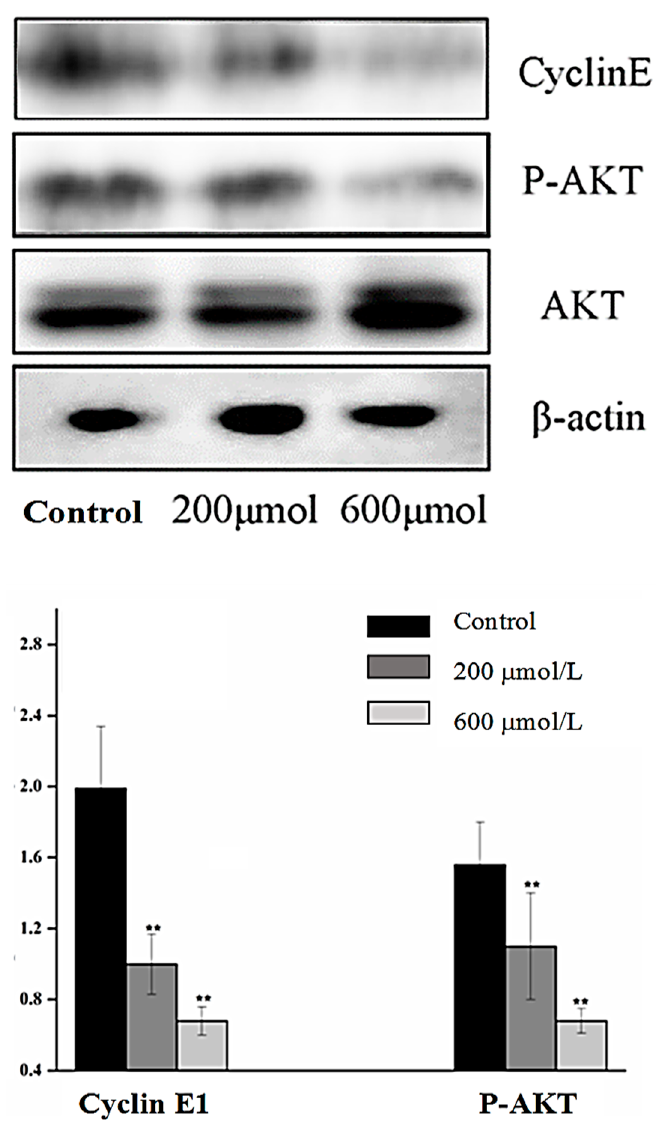
Figure 3. Images of Western blot analysis (top) and relative expression levels (bottom) of cyclin E1 / β -actin and P–AKT / AKT in control, 200 and 600 µ mol · L − 1 treatment groups.